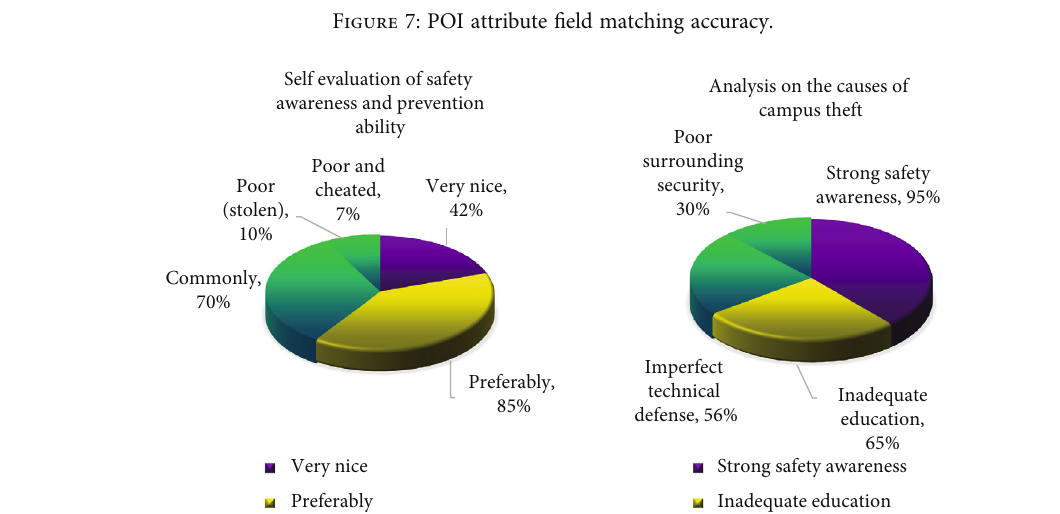
Figure 8: Self-defense awareness of college